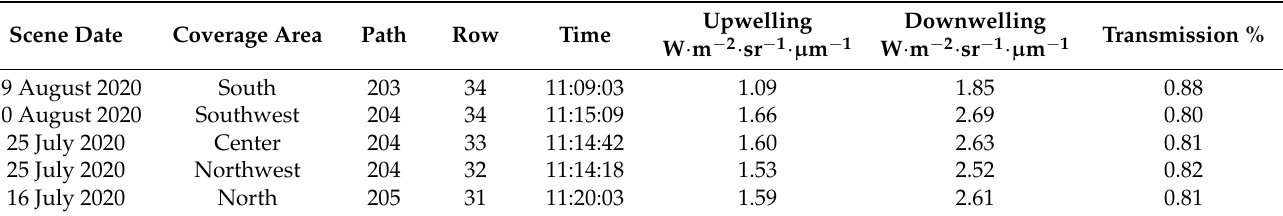
Table 2. Atmospheric correction parameters used for the study sub-regions: Upwelling and down- welling radiances, atmospheric